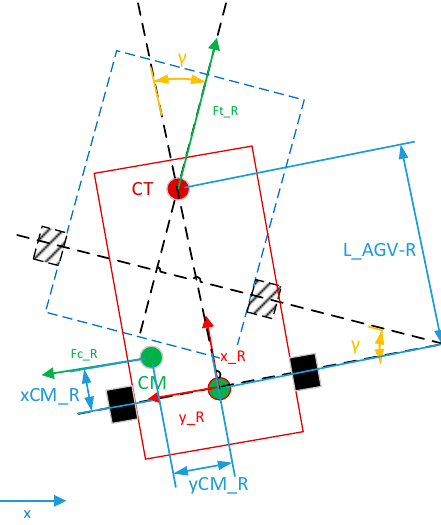
Figure 10. Forces acting on the trailer.